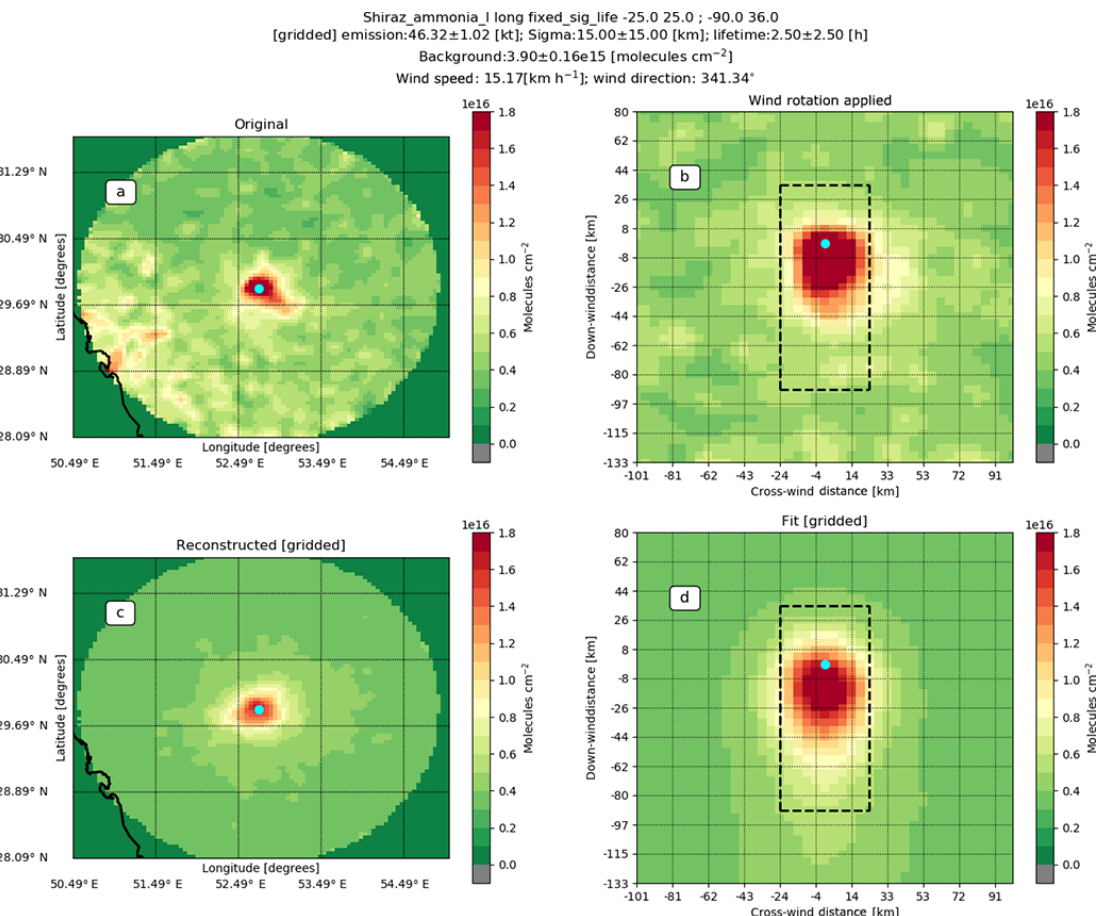
Figure D3. Fit example for the fertilizer plants in Shiraz, Iran. Panel (a) shows the original CrIS NH 3 total columns (2013–2017) gridded at a 0.05 ◦ × 0.04 ◦ (long, lat) resolution with the pixel-averaging technique with a 15km radius to represent the footprint. Panel (b) shows the same observations after applying the wind rotation algorithm and gridding the observations to a 3km × 4.5km grid. Panel (d) shows the fit to the observations and (c) the reconstruction of the initial plot using the parameters found in the